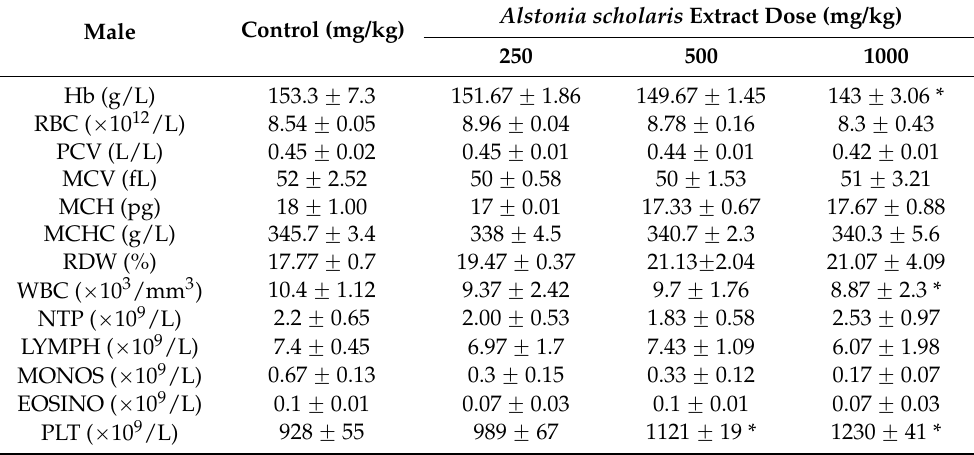
Table 10. Serum hematological values of male rats orally treated with the methanolic extract of the bark of Alstonia scholaris . Results were expressed as the mean ˘ S.E.M., n = 5. Male